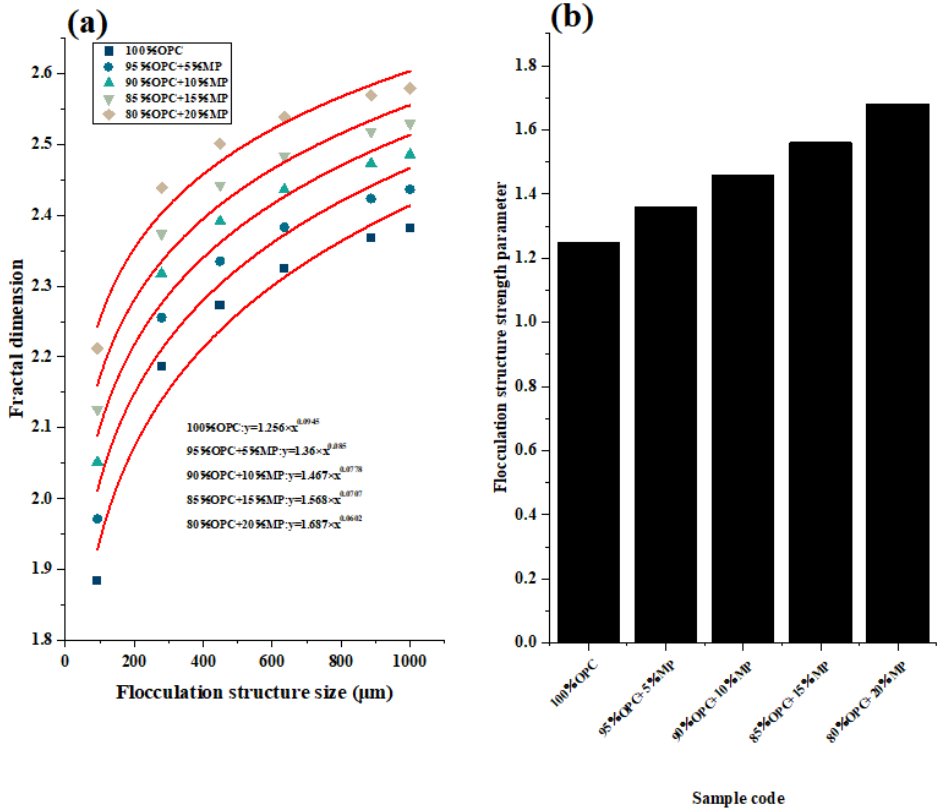
Figure 11. Curve fitting of fractal dimensions of different flocculation structure sizes and variations of flocculation structure strength parameter with W/CM ratios at different MP contents.